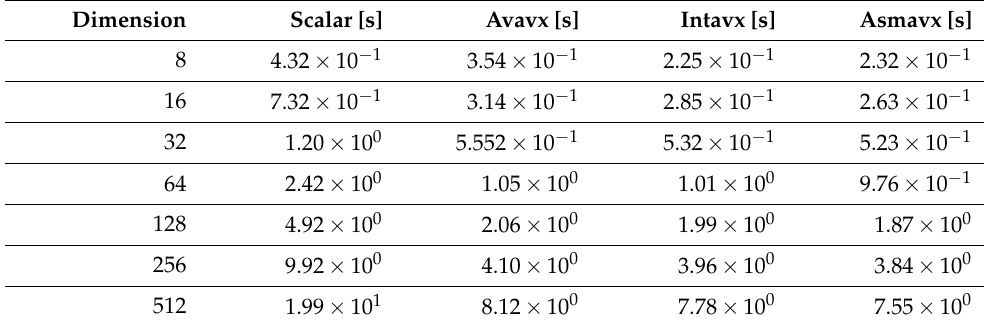
Table 3. Runtime performances of various PSO versions (32 particles, complete test